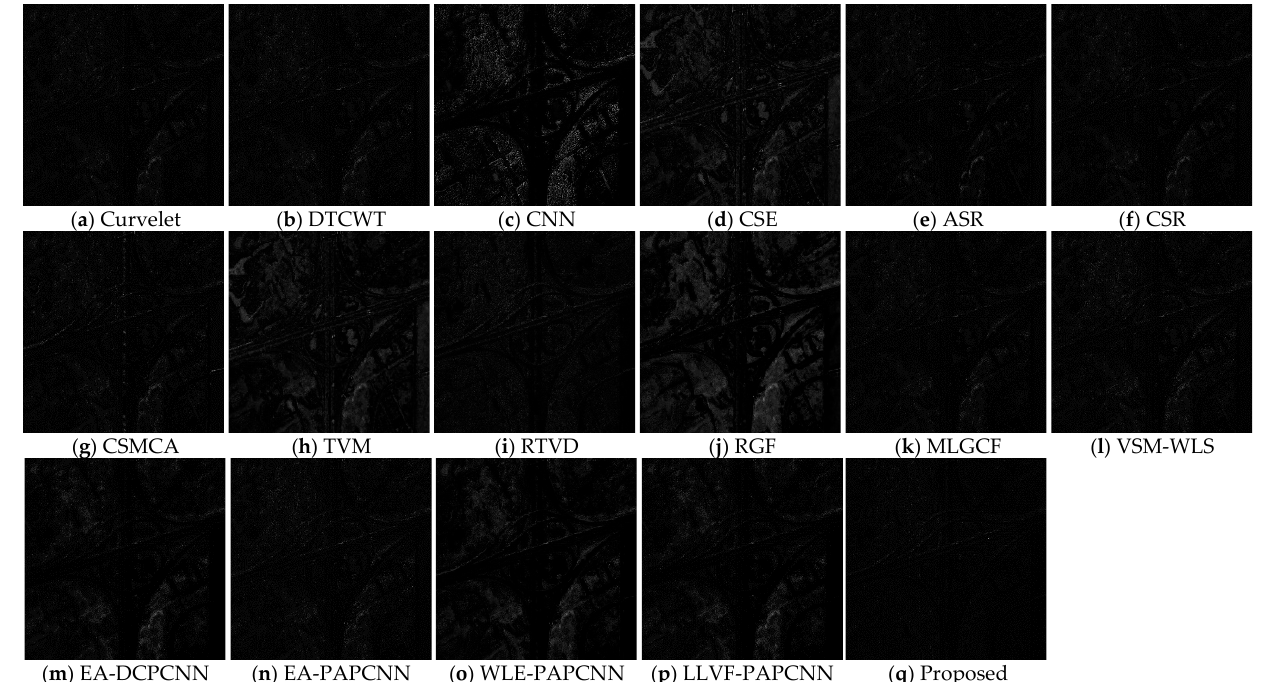
Figure 14. Error images corresponding to Pleiades images.